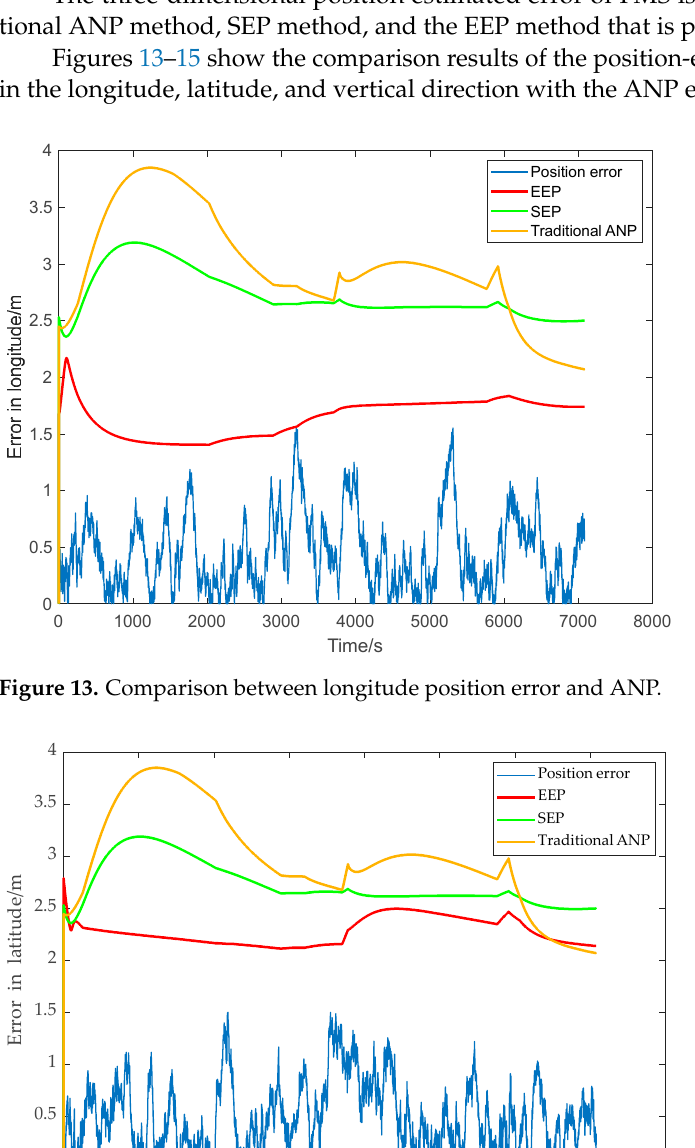
Figure 15. Comparison between altitude position error and ANP. The comparison of actual navigation performance evaluation algorithm results are shown in Table 3. Table 3. Comparison of actual navigation performance evaluation algorithm results. Statistical Items (RMSE)